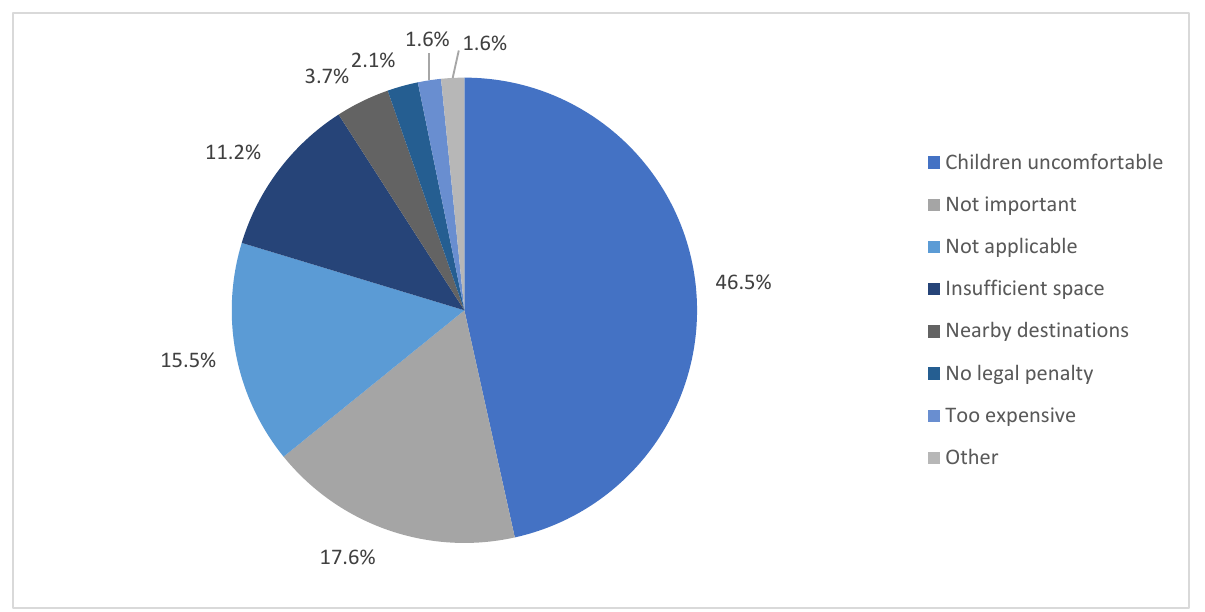
Figure 5. Reasons for ‘never/almost never’ restraining their eldest child while travelling in a motor vehicle ( n = 187). Table 8. Participant’s awareness of the upcoming introduction of CRS and booster seat legislation and frequency of restraint use for their eldest child while travelling in a motor